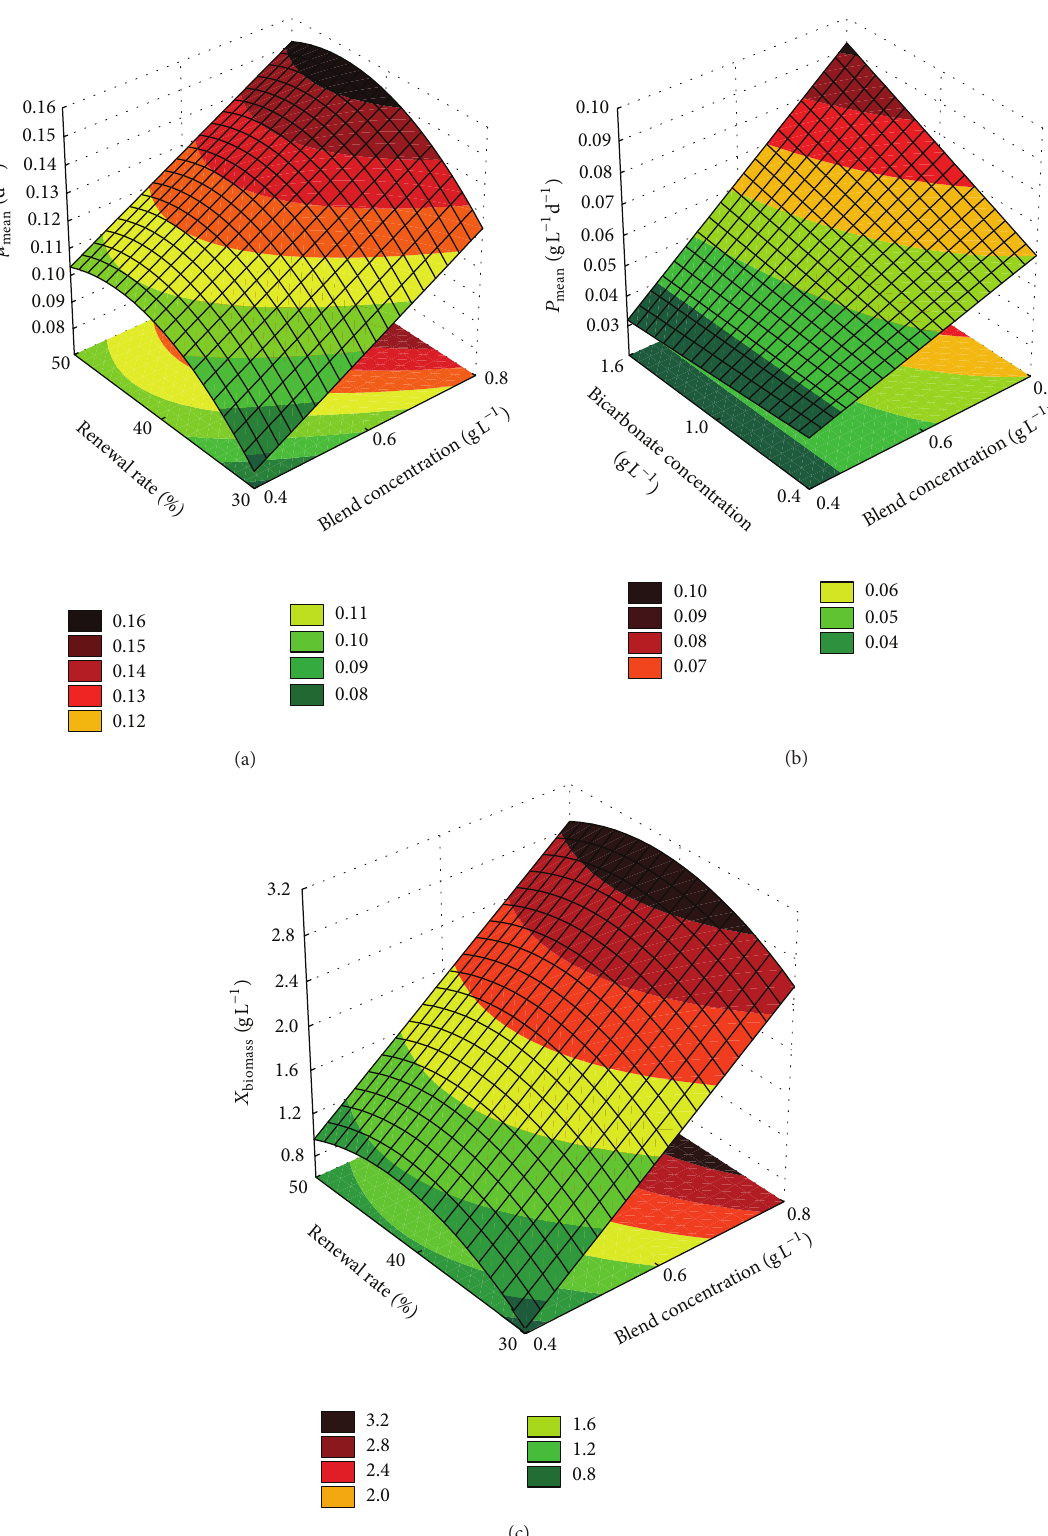
Figure 3: Response surfaces and contour lines for (a) specific rate as a function of blend concentration and medium renewal rate using 1.60g L −1 of sodium bicarbonate concentration; (b) productivity as a function of the sodium bicarbonate concentration and blend concentration using a medium renewal rate of 40%; and (c) generated biomass concentration during cultivation as a function of the medium renewal rate and blend concentration using sodium bicarbonate concentration of 1.60g L −1